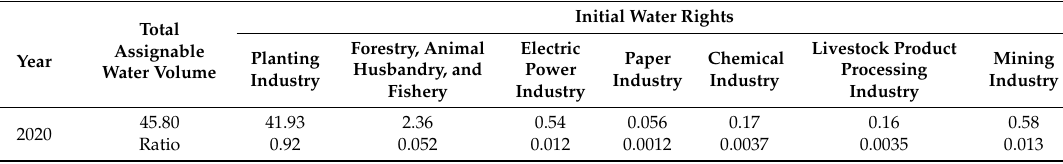
Table 5. Initial water rights distribution for Bayannur City in 2020.